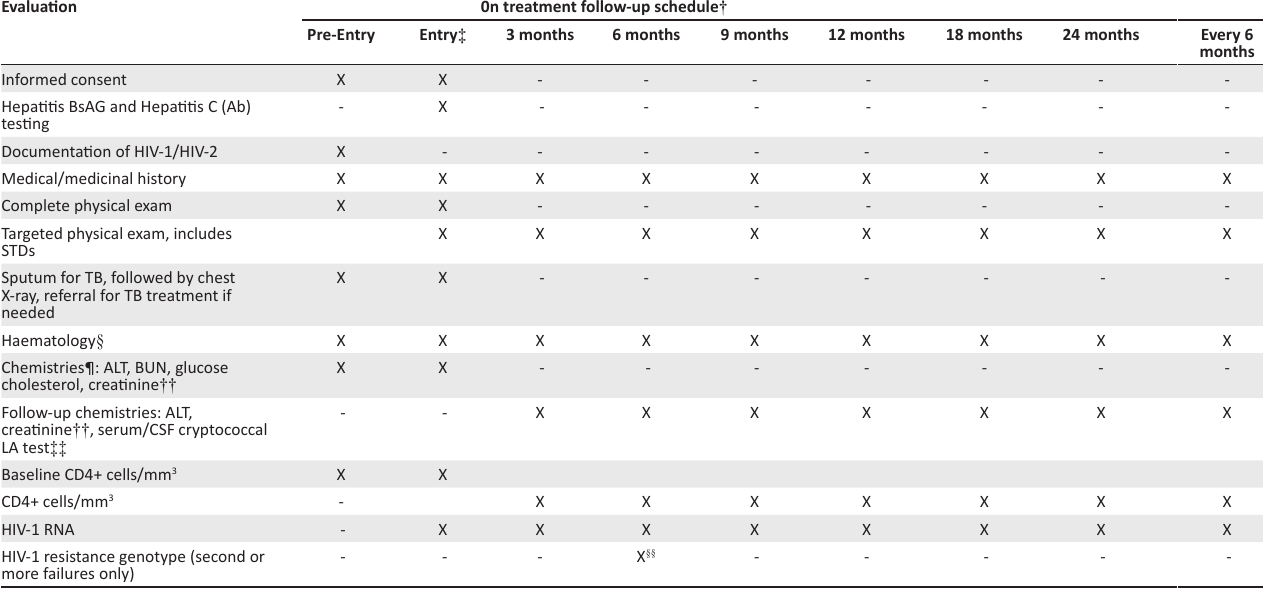
TABLE 1: Antiretroviral therapy regimen testing schedule.